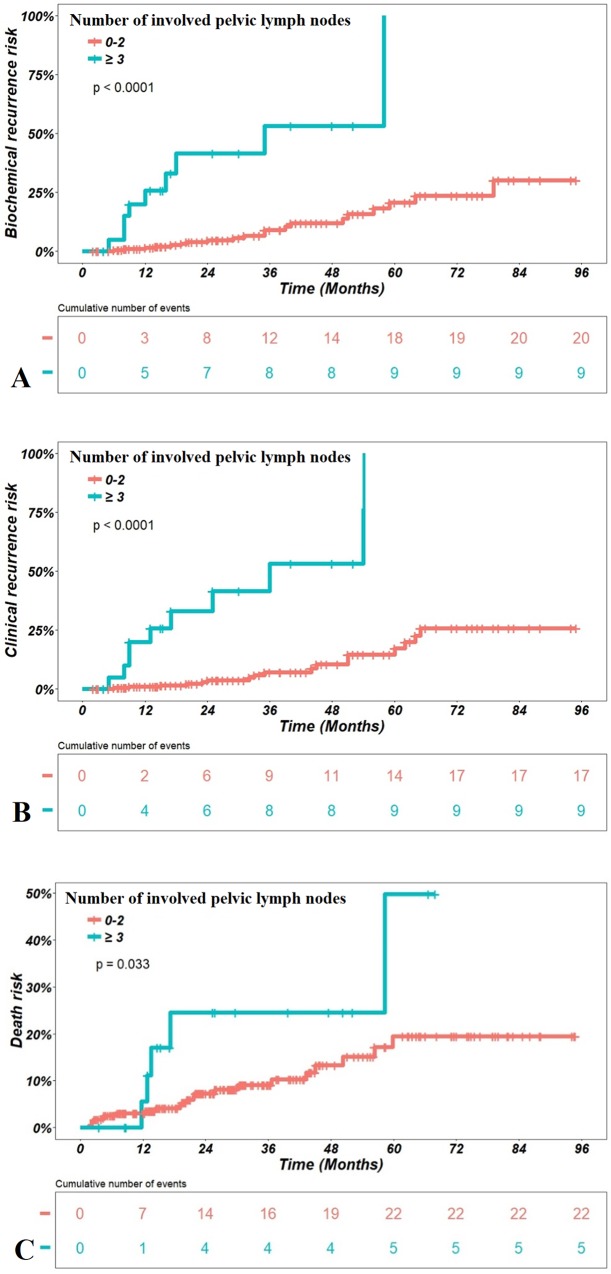
Impact of lymph node involvement (≤ 2 or ≥ 3 lymph nodes on MRI) on carcinological outcomes.(A)on biochemical recurrence, (B) on clinical recurrence, (C) on death. Clinical recurrence was defined as at least local or pelvic lymph node or metastasis recurrence. The p value has been calculated from the logrank test.